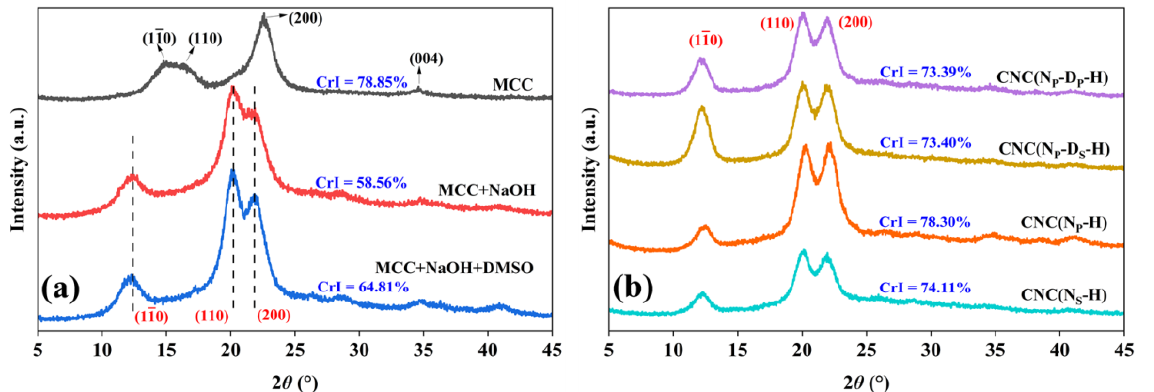
Figure 5. ( a ) XRD patterns of MCC, MCC after alkaline treatment and MCC after alkaline treatment and swelling treatment; ( b ) XRD patterns of CNC samples prepared through different pretreatment routes. Table 1. The crystallinity and crystallite size for different